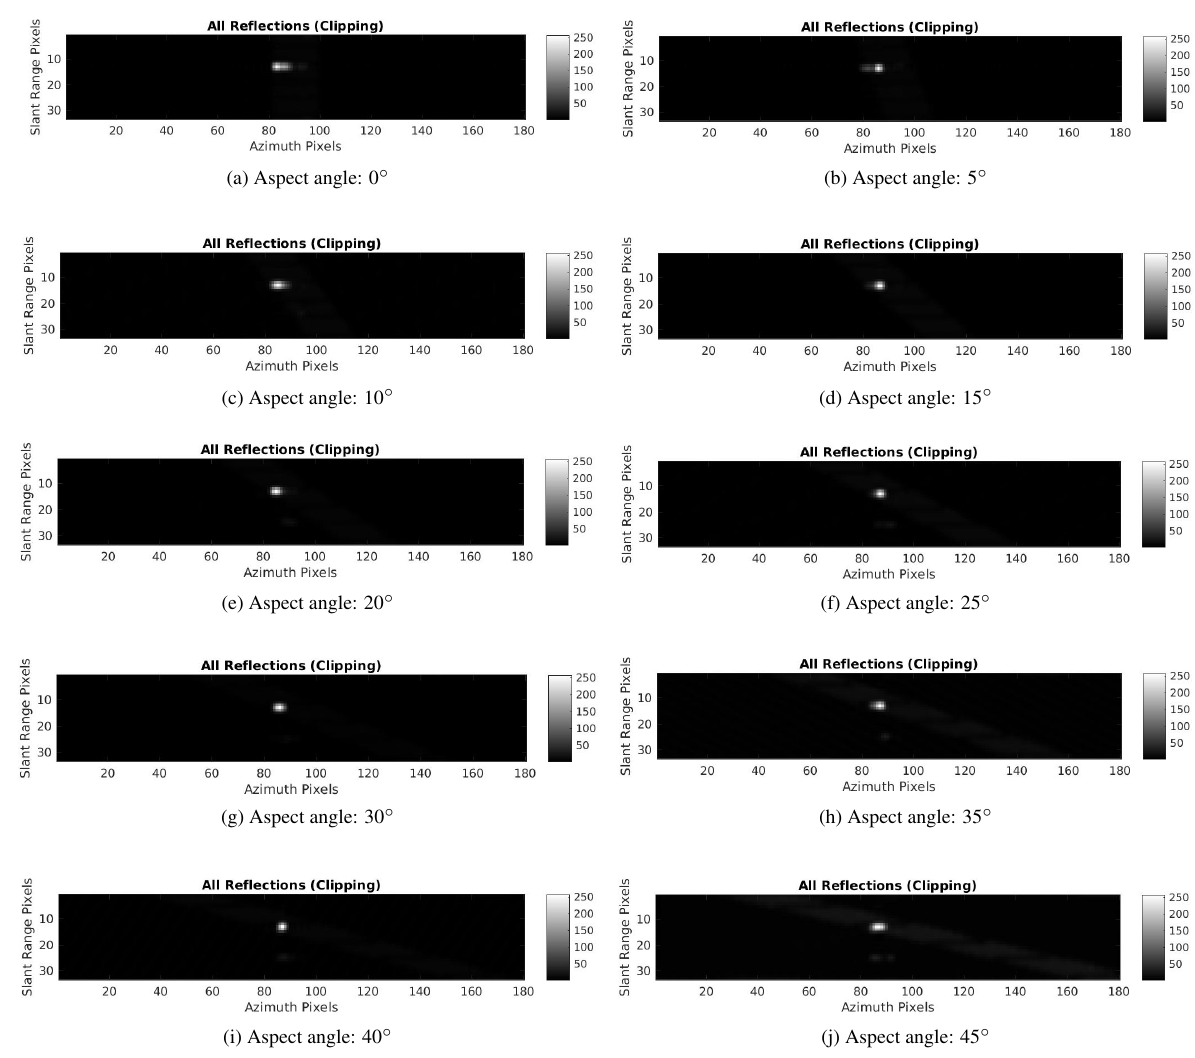
Figure 6. Simulated SAR images for light pole (staring spotlight